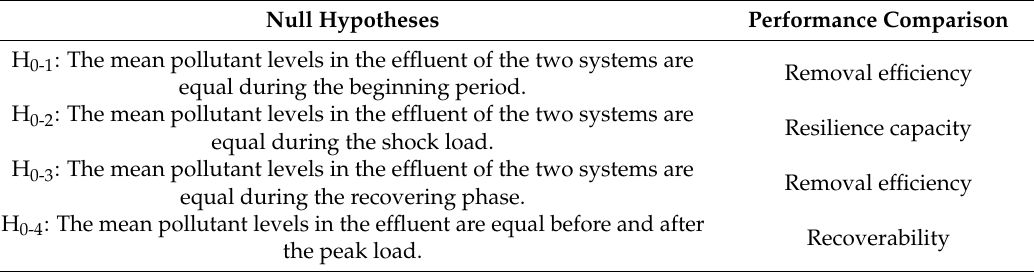
Table 1. Four null hypotheses with their relevant